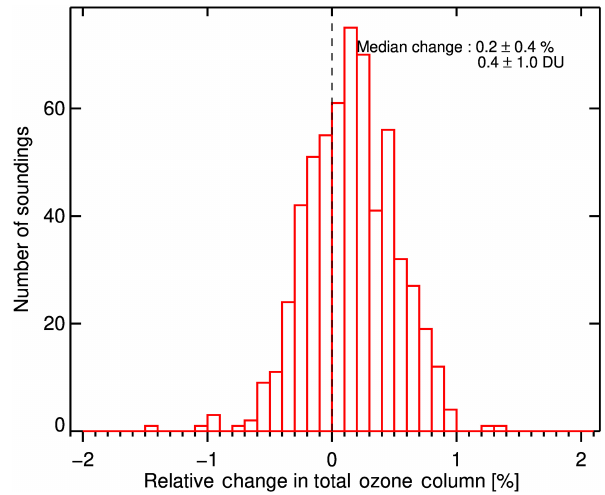
Figure 12. Change in the total ozone column due to the correction